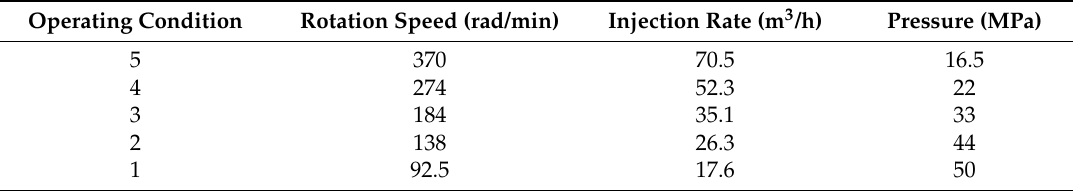
Table 1. Parameters of type BYW fracturing pump system.